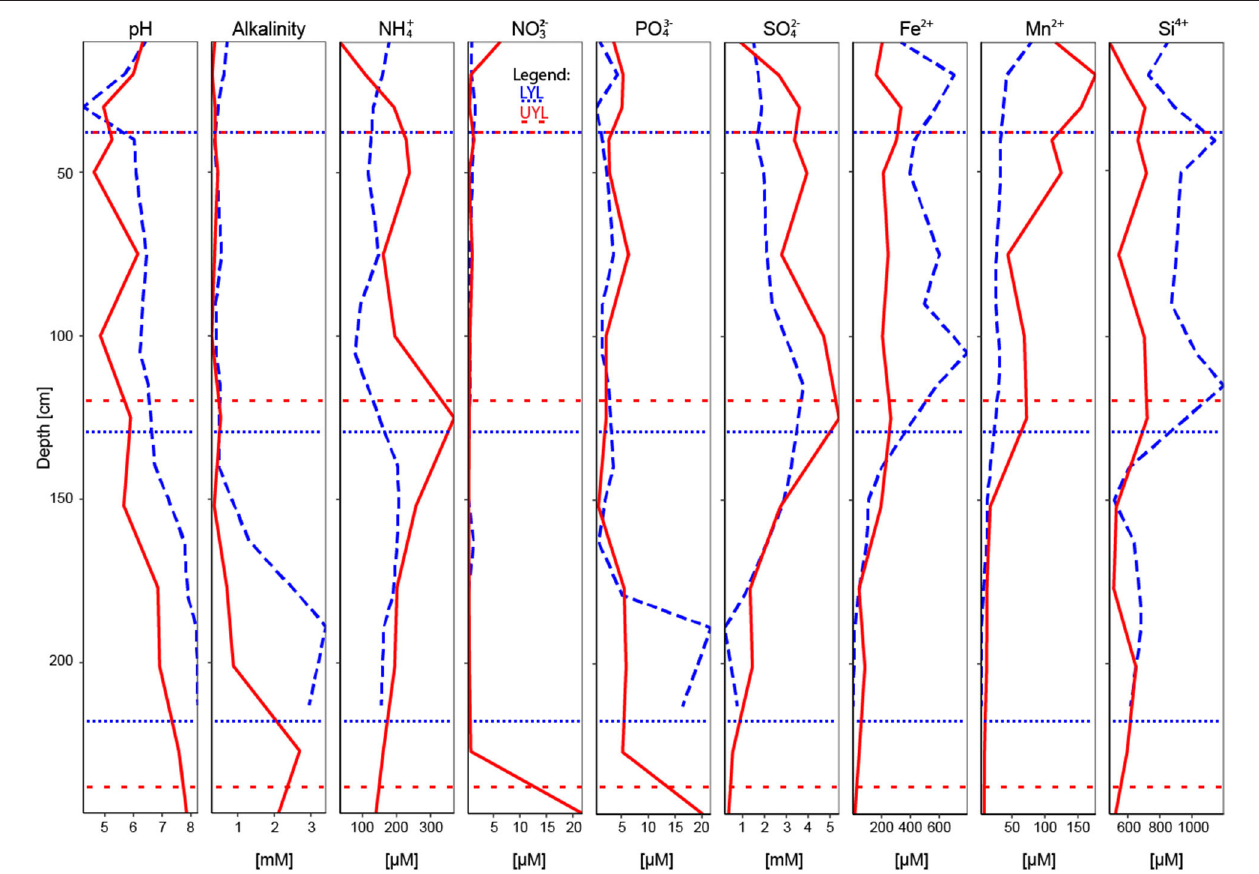
FIGURE 2 | All pore water variables used in the study, including pH and alkalinity. Blue dashed line: LYL; red line: UYL. Horisontal dotted and spaced dotted lines refer to lithological separation into units for LYL and UYL, respectively.